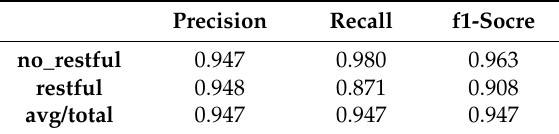
Figure 7 indicates the confusion matrices of the test result with different preprocessing methods.